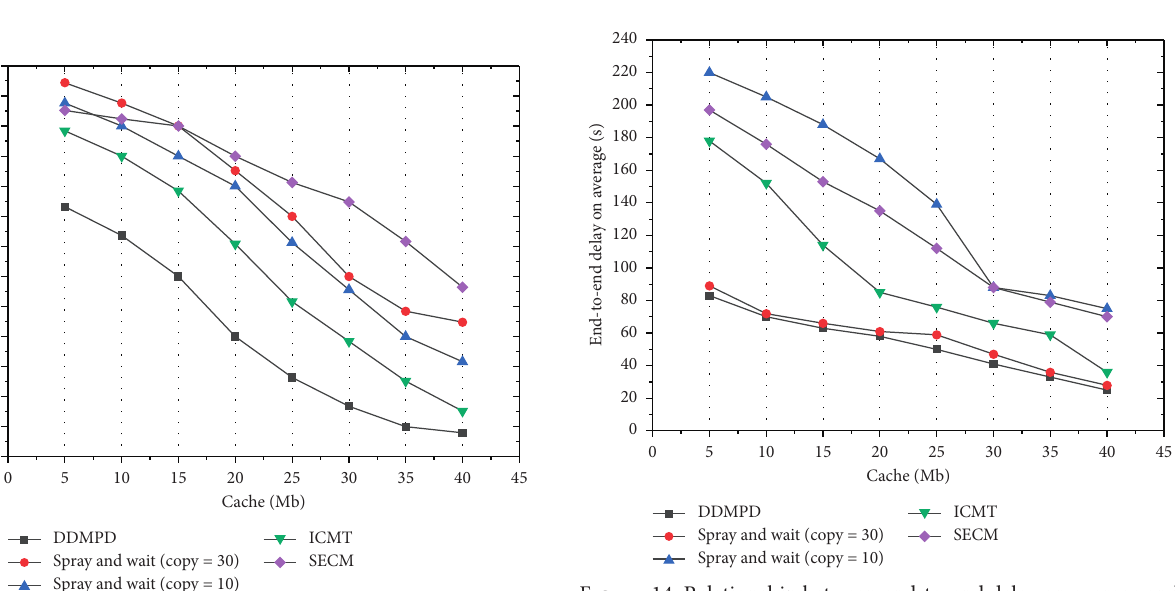
Figure 12: Relationship between average overhead and